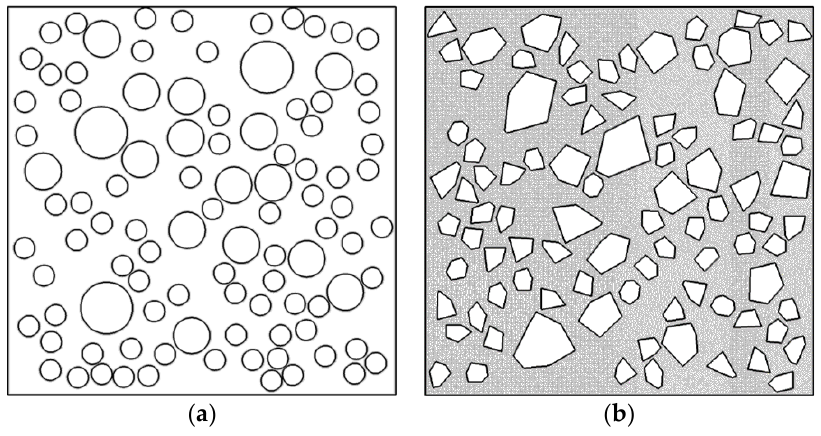
Figure 11. Circle aggregate model of specimens: ( a ) NC50; ( b )